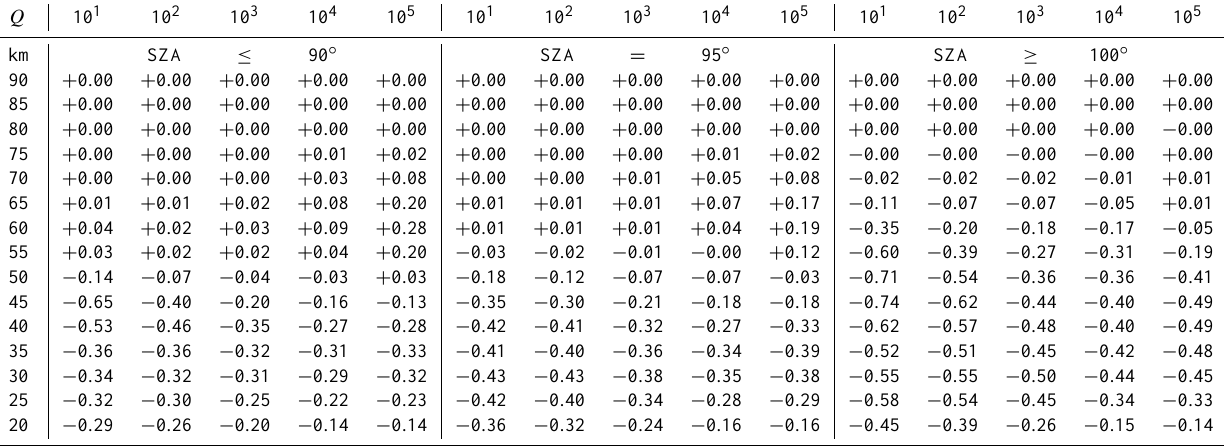
/Q for January SH. 2